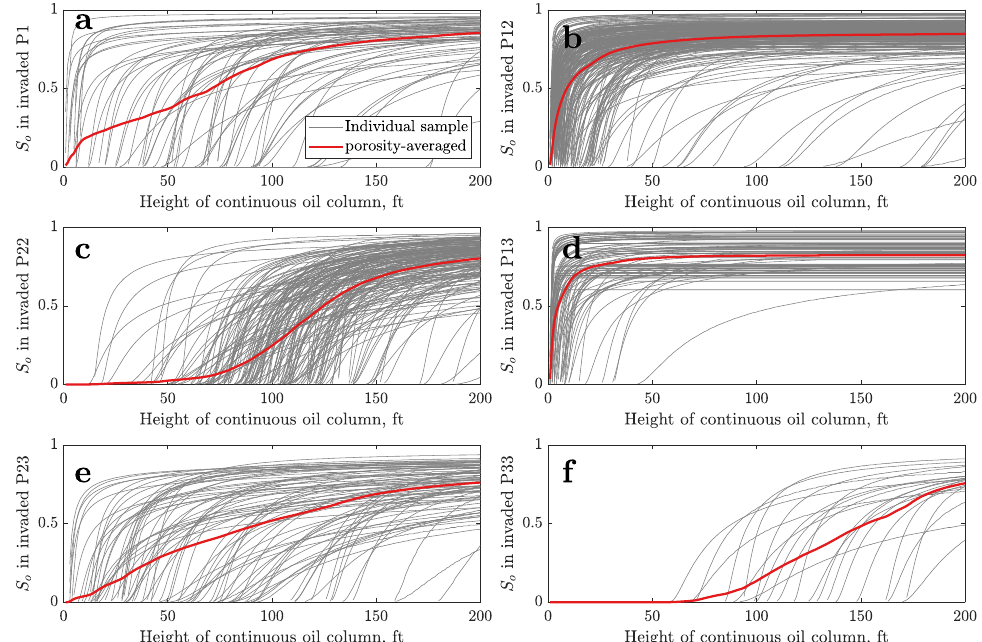
Figure A2. The heights of vertical oil columns necessary to drain the carbonate rock samples with different sets of porositons. From a to f clockwise: oil saturations in samples that contain only Porositon 1 in M, Porositons 1 and 2 in M, Porositon 2 in M, Porositon 3 in 1 in M, Porositons 2 and 3 in M, and Porositon 3 in